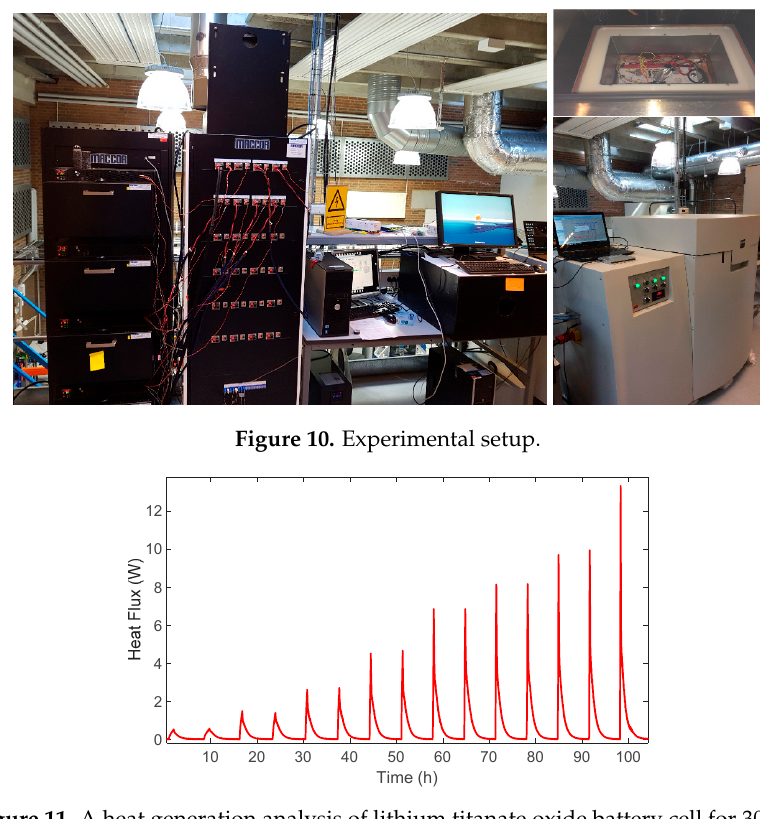
Figure 11. A heat generation analysis of lithium titanate oxide battery cell for 300 K.